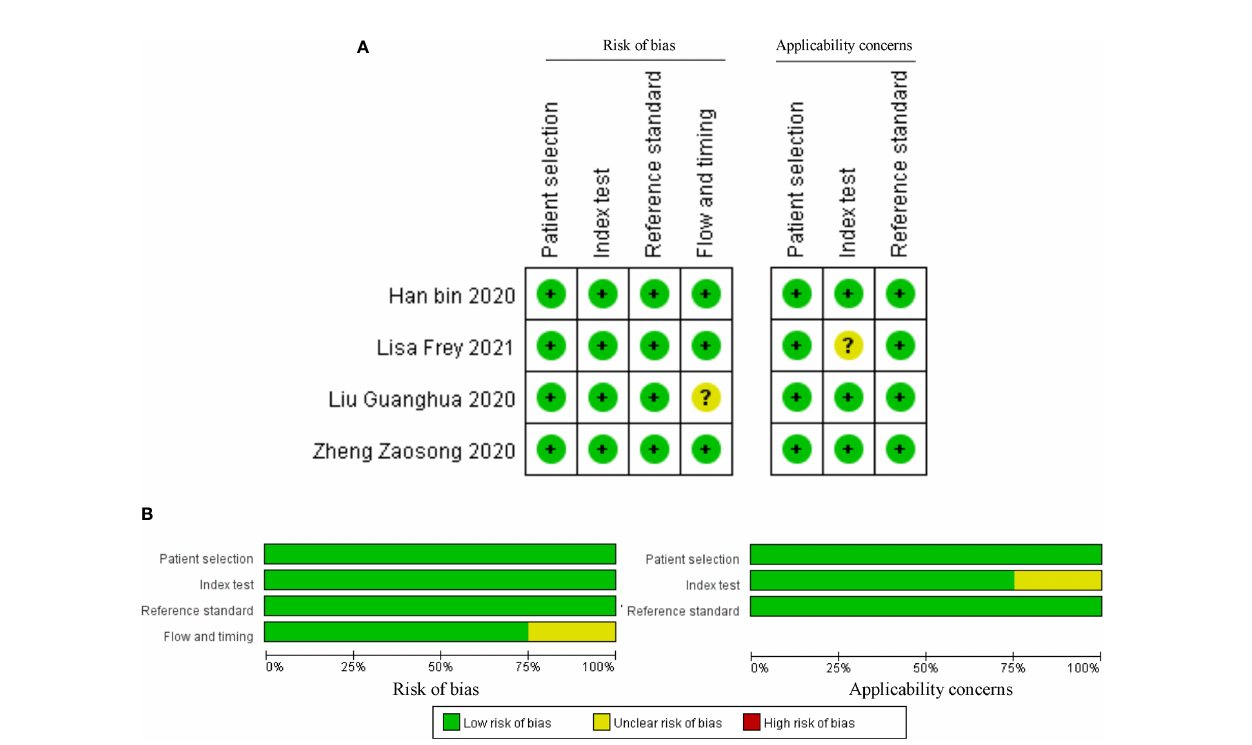
FIGURE 3 | Quality assessment by the QUADAS II. (A) each bias risk item for each included study; (B) each bias risk item is presented as a percentage for all included